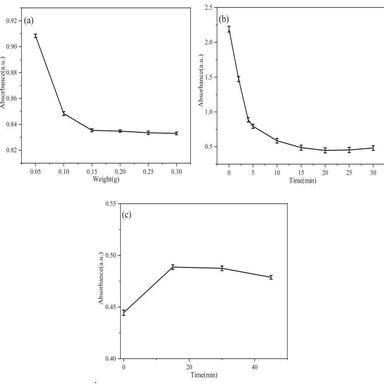
Absorbance curves of (a) CO2-responsive phase transfer materials amount; (b) time of bubbling CO2; (c) heating time to N2.